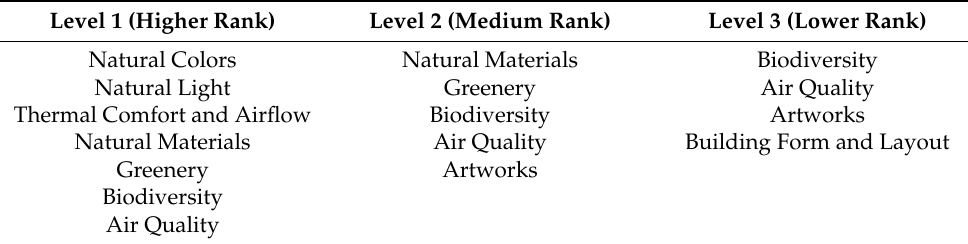
Table 12. Weighting of biophilic design attributes for workplace by